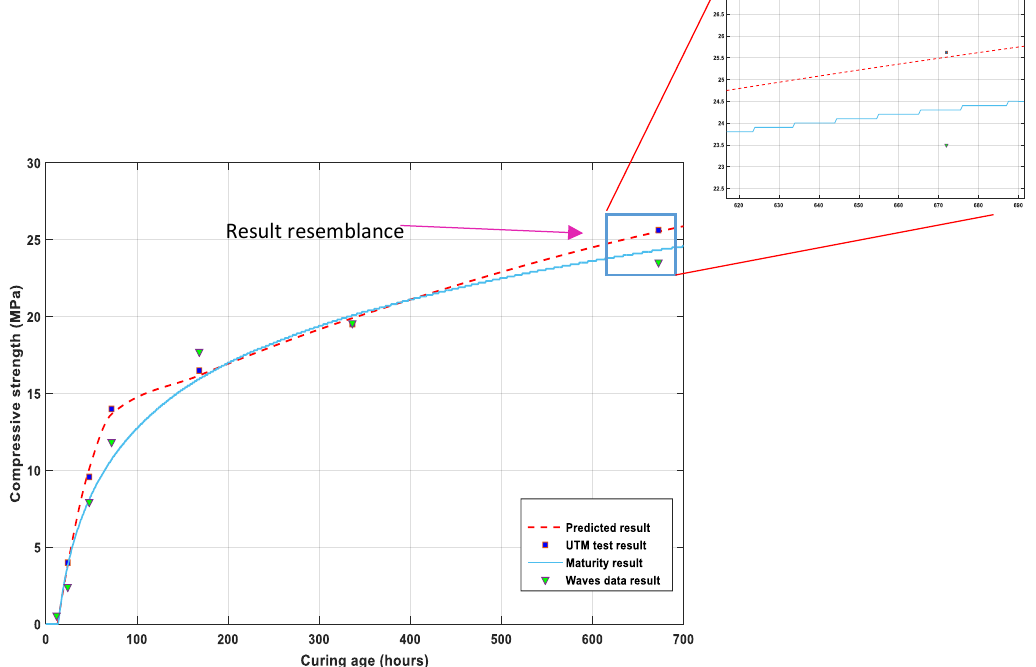
Figure 13. Data comparison for the concrete compressive strength with the maturity- and ultrasonic velocities-modified data.